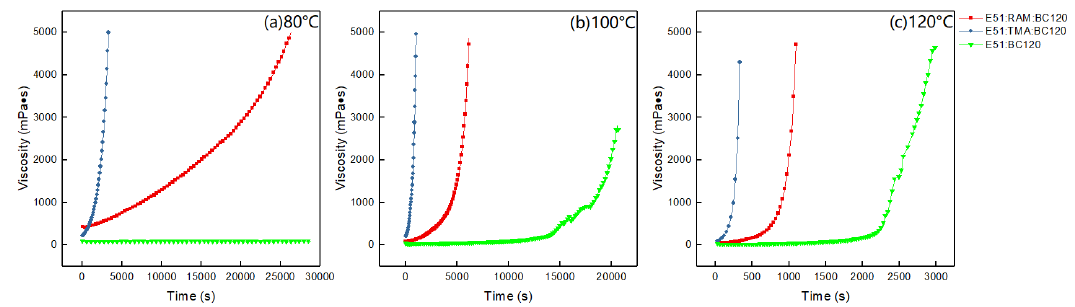
Figure 6. The viscosity-time curves for three experimental systems at ( a ) 80 ° C, ( b ) 100 ° C, ( c ) 120 ° C. The viscosity-time curves of the 3 models at 80 ° C, 100 ° C and 120 ° C are also shown